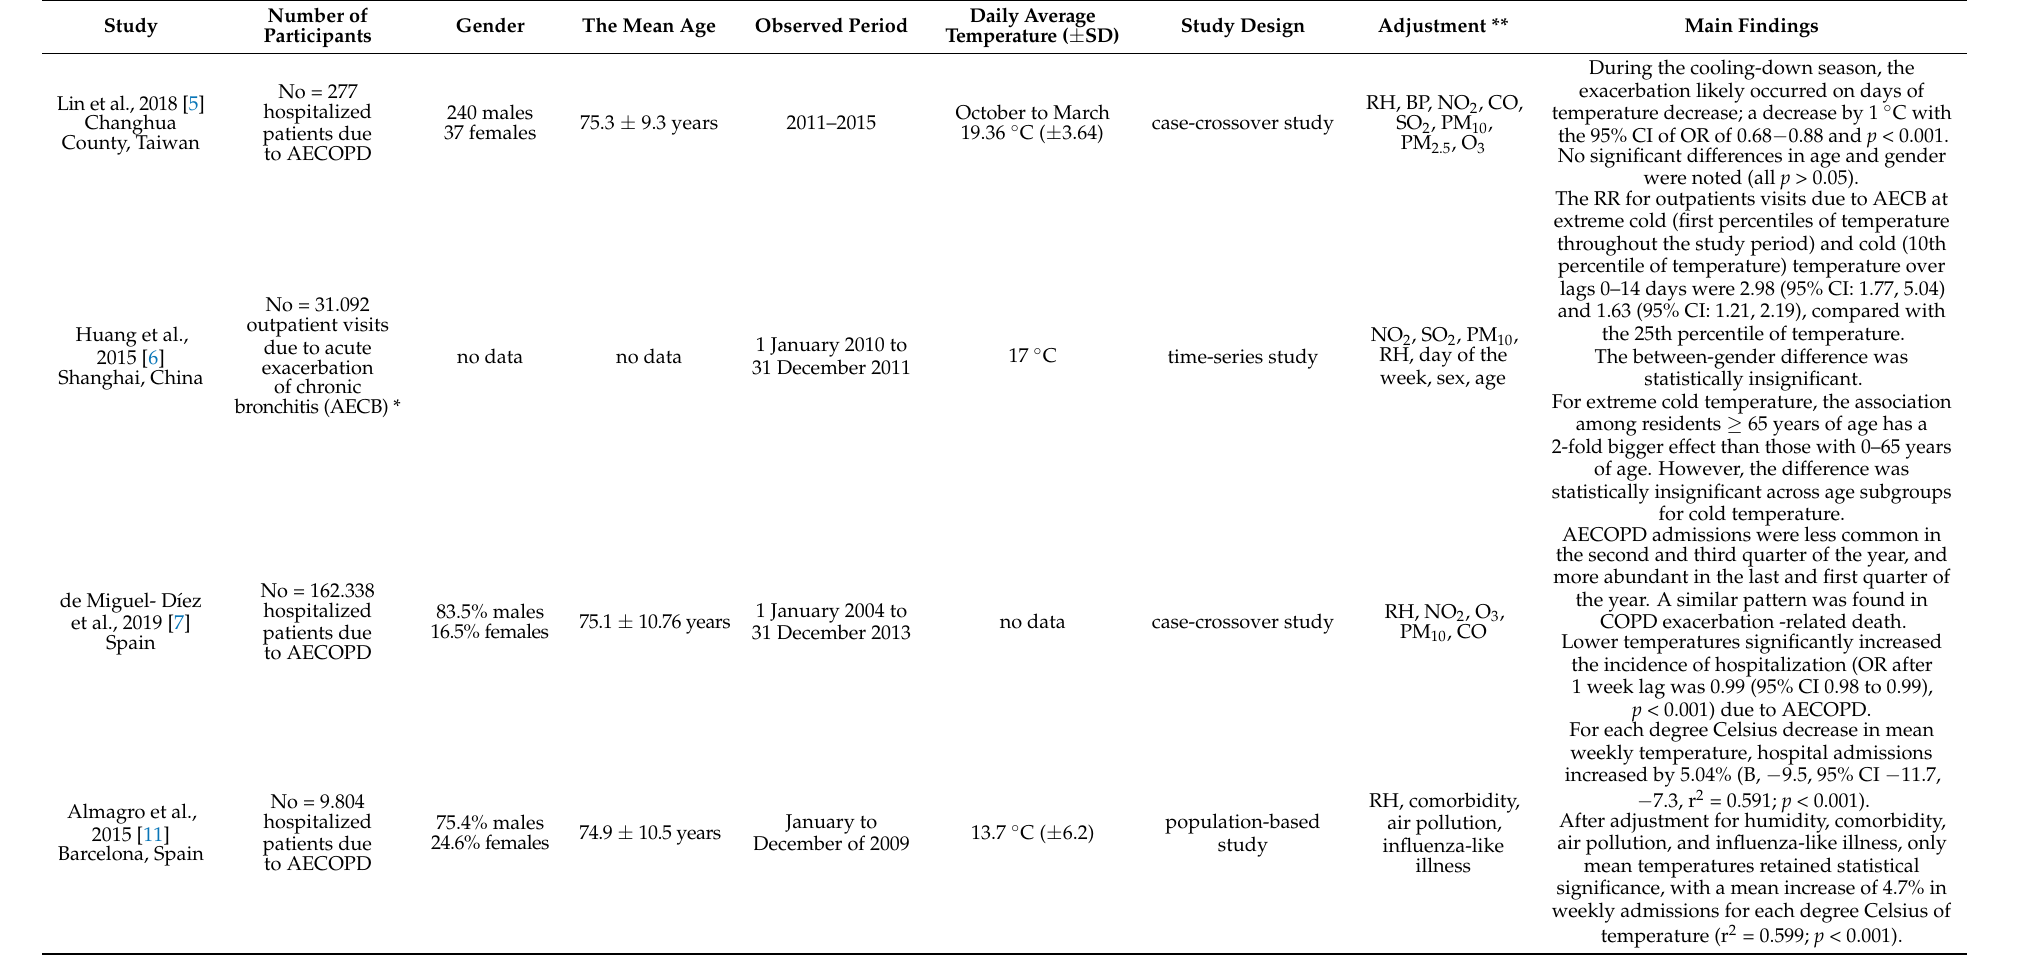
Table 1. The effects of decreased air temperatures on AECOPD hospitalizations/outpatients’